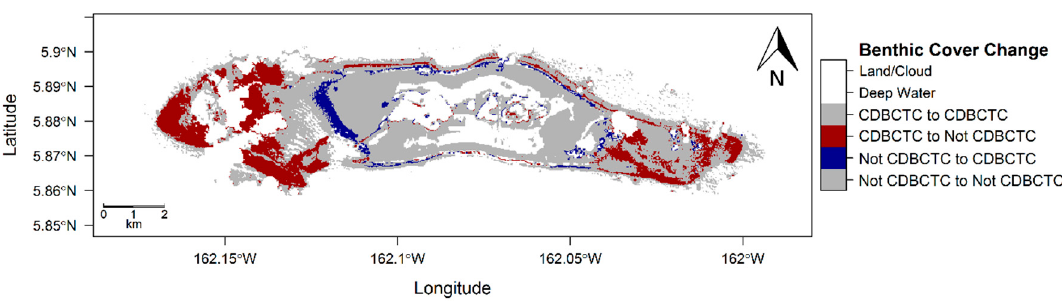
Figure 5. Posterior probability map for the Palmyra Atoll area of interest (top, 2001 and bottom, 2015).